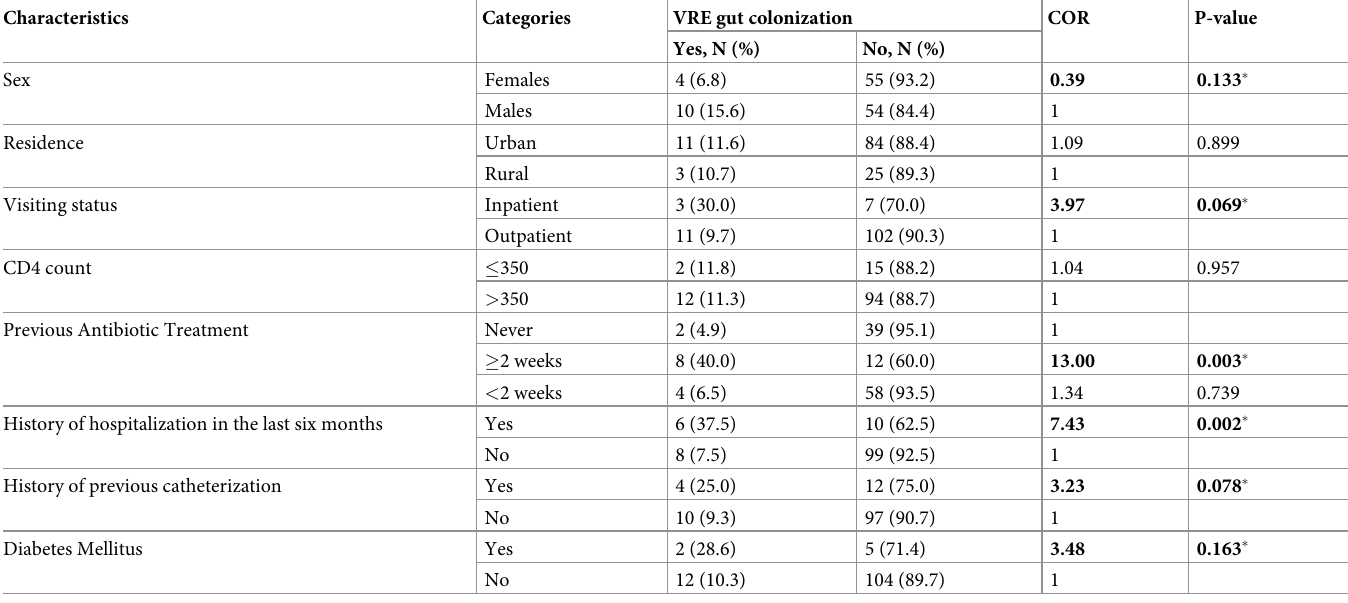
Table 4. Bivariable logistic regression analysis on factors affecting vancomycin resistant Enterococci among clients attending ART clinic at Arba Minch General Hospital, Southern Ethiopia October 2020. Characteristics